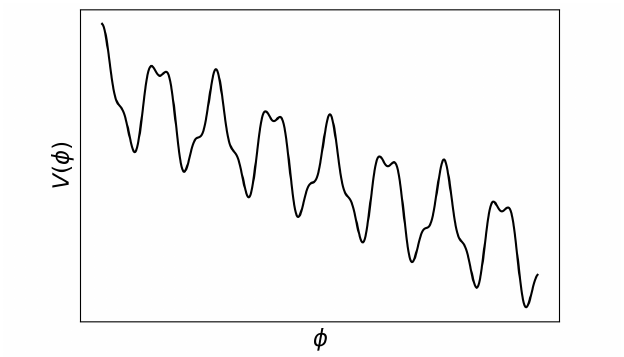
Figure 2 . The sketch of the potential given in eq. (3.22). After the axion relaxation starts, relaxion field φ rolls down and produces the particles in particle production state until get trapped in one of the